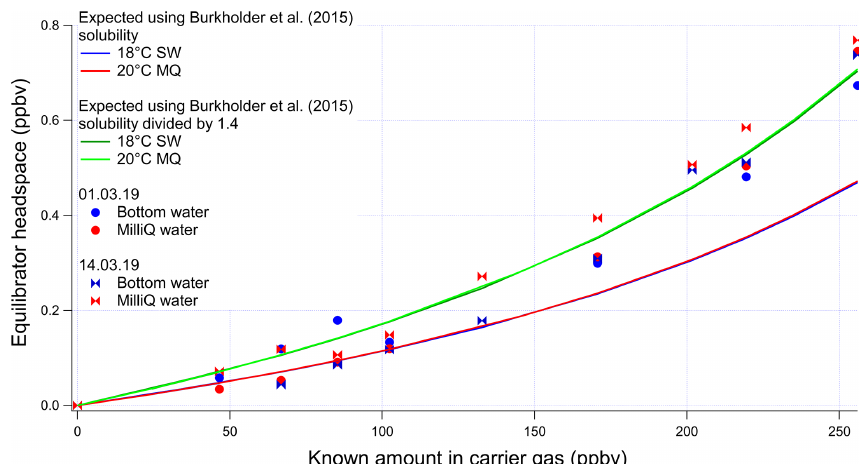
Figure A2. Invasion calibrations for acetone carried out during the deployment and using different types of water (SW: seawater; MQ: Milli- Q water). Bottom SW refers to seawater collected from well below the mixed layer. The non-linear response is due to the changing gas flow as more standard gas is added to the zero-air carrier gas, which alters the purging